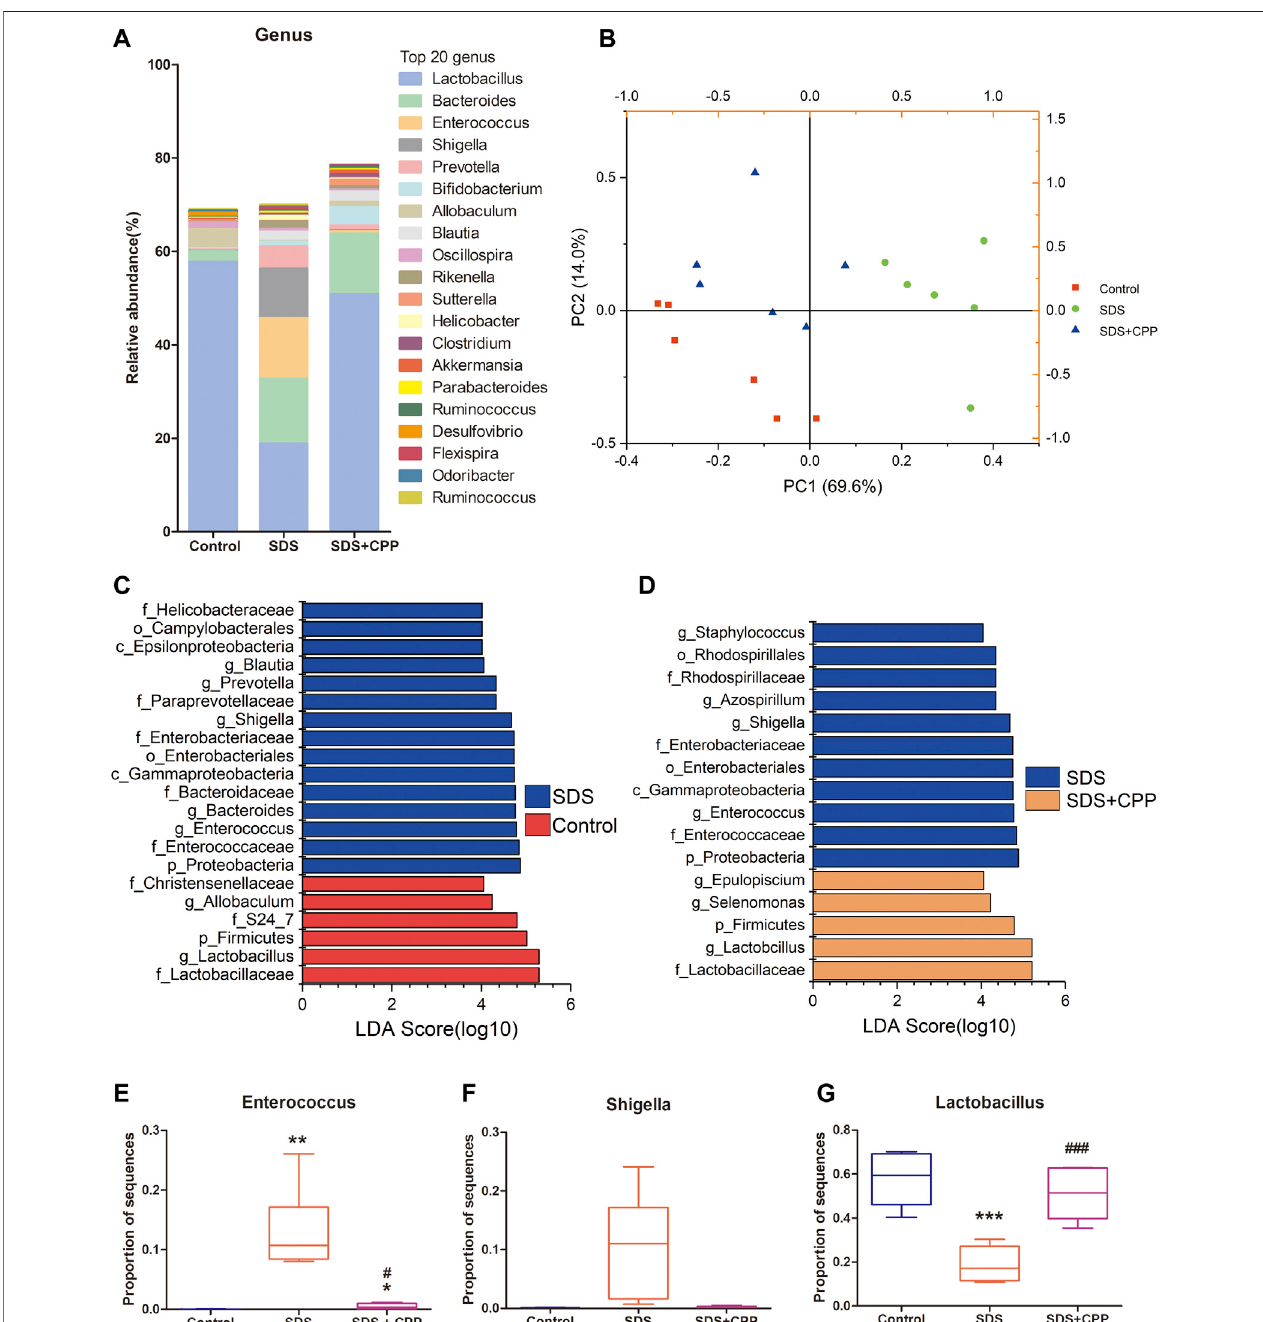
FIGURE 2 | Effect of CPP gavage on the gut microbiota. (A) The intestinal microbiota composition analysis at genus level, the top 20 genera in control, SDS and SDS+CPPgroupswerevisualizedbyhistogram. (B) PCAanalysisofgutmicrobiotabasedontheOUTdataofeachsampleinthethreegroups. (C) LEfSeanalysisofthe dominant biomarker taxa between the control and SDS group. (D) Discriminative taxa determined by LEfSe between SDS and SDS + CPP group (log 10 LDA > 4.0). Relative abundance of (E) Enterococcus , (F) Shigella , and (G) Lactobacillus in colonic contents of the three groups. Data were expressed as box-whisker plots (E – G) .Theboxesindicatethe25thto75thpercentilesofdata,andlineswithintheboxrepresentmedianvalues.Thewhiskersrepresentthelowestandhighestvalue( n = 6). * p < 0.05, ** p < 0.01, *** p < 0.001 vs. mice in control group; # p < 0.05, ## p < 0.01, ### p < 0.001 vs. mice in SDS group. LDA, linear discriminant analysis.